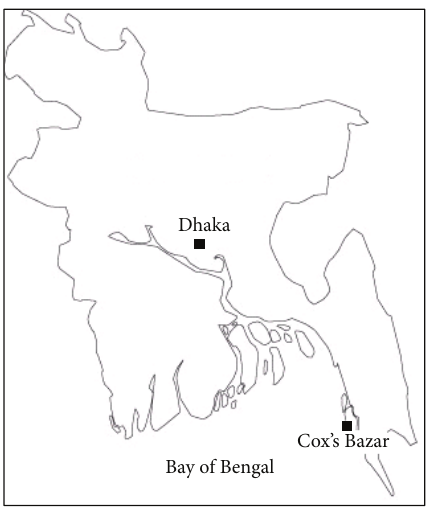
Figure 1: Sample collection